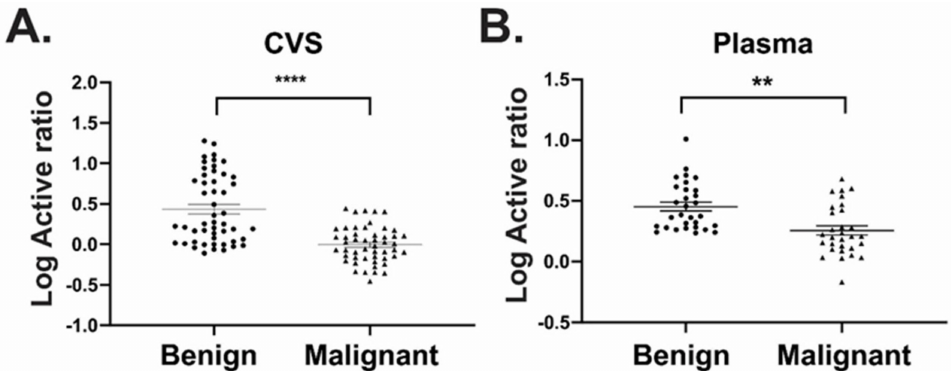
Figure 8. ART performed using either plasma or cervicovaginal swabs discriminated between benign and malignant disease. CXCL10 was measured using ART in ( A ) cervicovaginal swabs (CVS) and ( B ) matched plasma samples from patients with either benign or malignant ovarian cancer. n = 50/group; **** p < 0.0001, ** p <